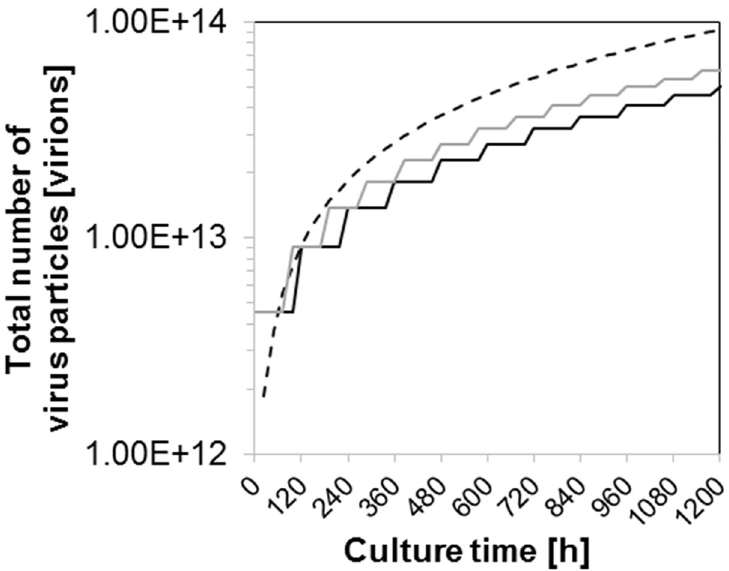
Fig 8. Total number of virus particles produced with a tubular bioreactor system (dashed line) and two batch bioreactors (continuous lines) using suspension MDCK cells. A stainless steel batch (black line) and a single-use batch (grey line) are shown. All cultivation systems with 711 mL working volume, and a maximum virus titer of 6.4 × 10 9 virions/mL in the harvest (based on an HA titer of 2.5 log 10 (HA units/100 μ L)). First batch harvest normalized to 0 h; first PFBR harvest at 20 h. Batch cycles of 4 and 5 days for the single-use and stainless steel batch process, respectively.